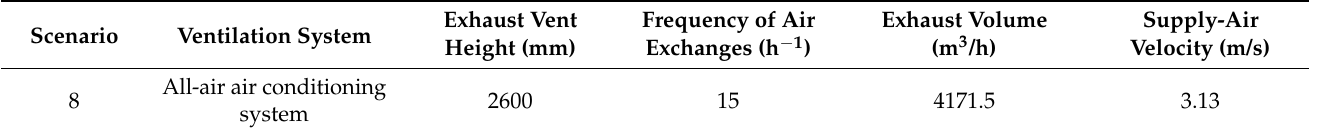
Table 8. The all-air air conditioning system boundaries.